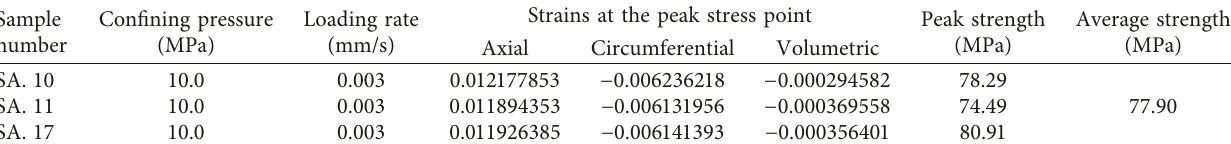
Table 1: Test results of the limestone samples in the conventional triaxial compression tests.